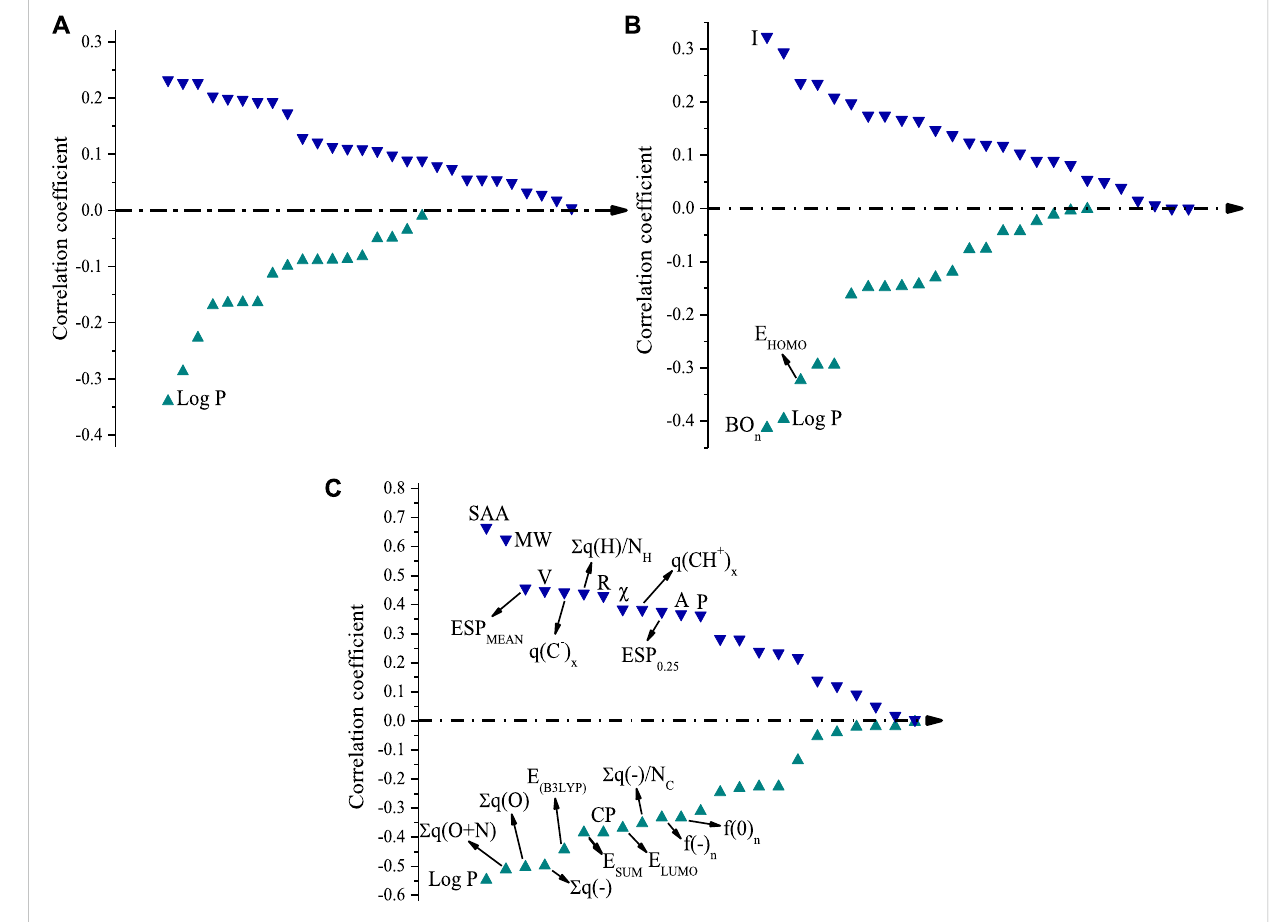
FIGURE 2 Correlation coef fi cient between R exp by AlCl 3 and the molecular parameters of the dyes. (A) pH = 4, (B) pH = 7, and (C) pH = 10.